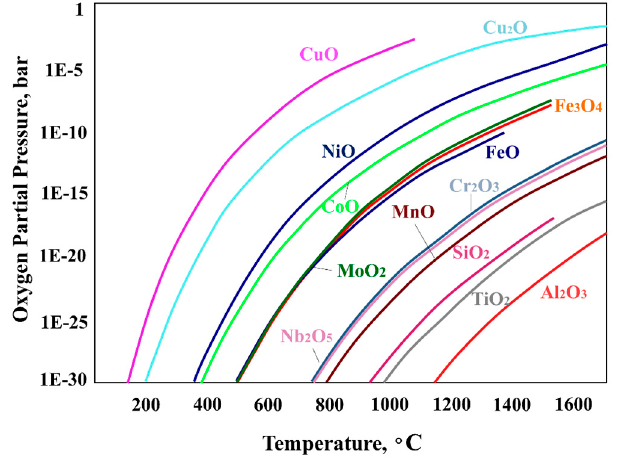
Figure 14. Illustration of equilibrium oxygen partial pressure for some metal oxides/metal systems, Reproduced with permission from [28]. Elsevier, 2012. reproduced with permission from [28]. Elsevier,